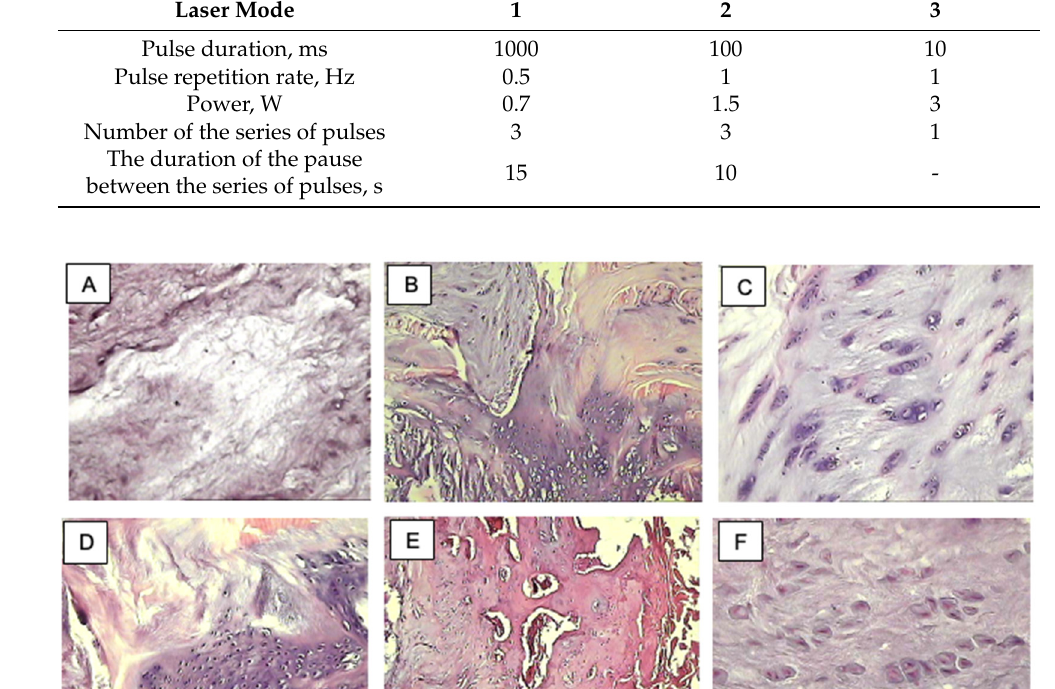
Table 1. Laser mode selection for clinic. Wavelength 1560 nm, number of pulses in a series 10.